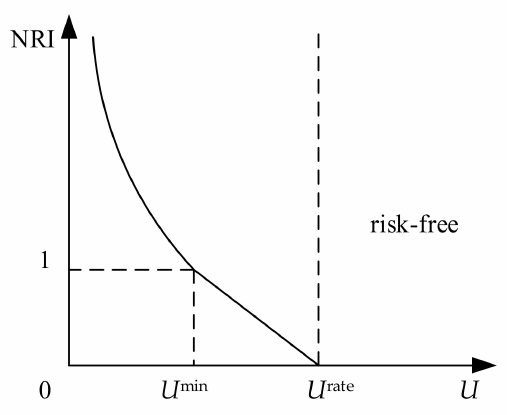
Figure 2. Normalized risk index (NRI) of bus